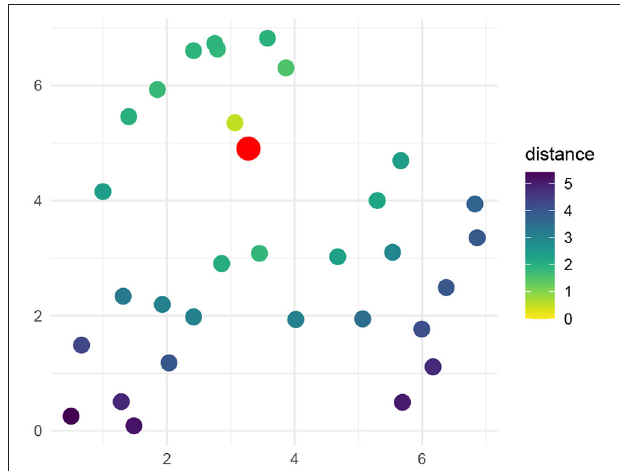
FIGURE 4 | Example of an idealized semantic metric of words as used for basic simulations. Thirty-two words are placed randomly in a two-dimensional bounded Euclidean space of size 7 × 7. A target word is indicated in red. The remaining points are colored according to their distance from the target